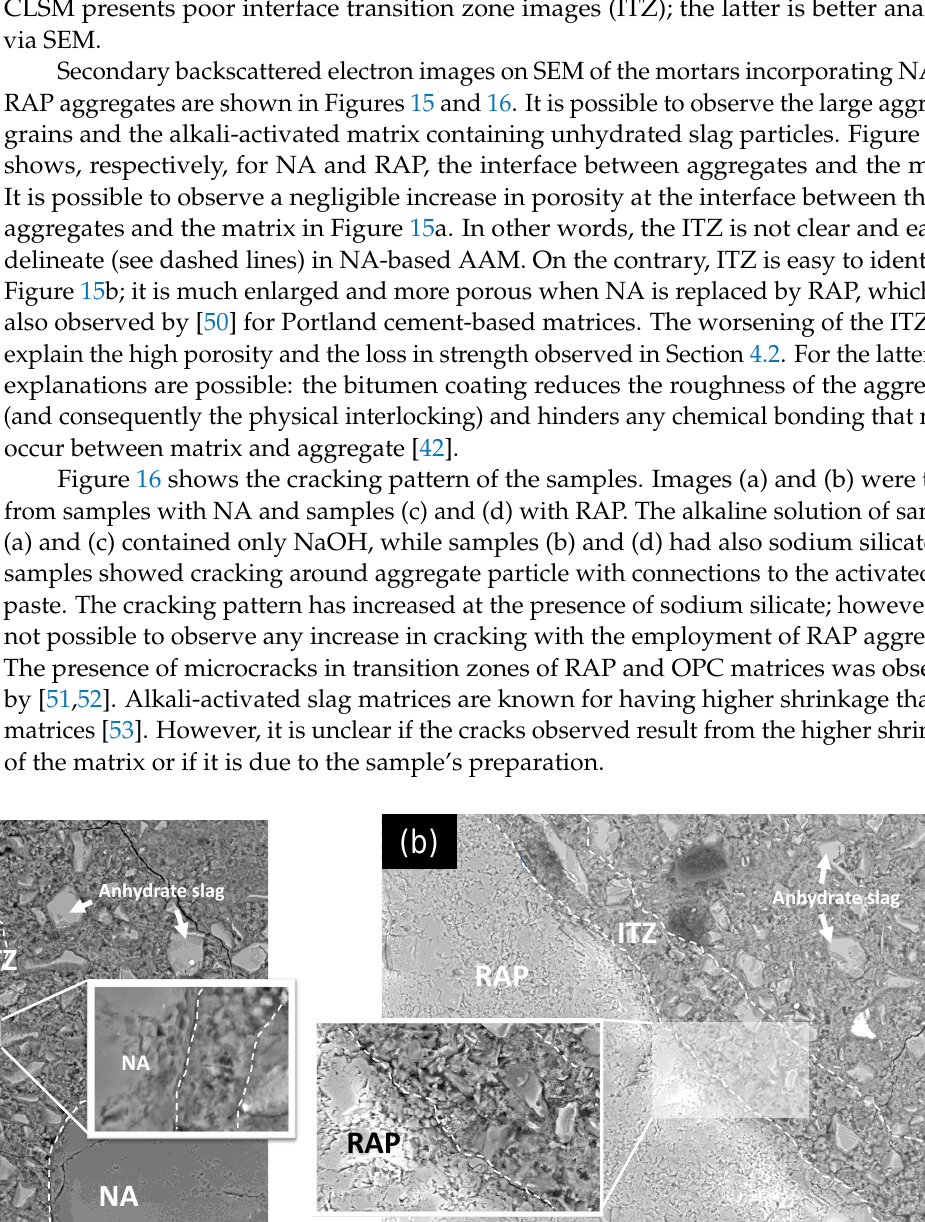
Figure 16. Evolution of cracking ( a ) N6M0, ( b )N6M1, ( c )R6M0, ( d ) R6M1. 5. Conclusions This paper studied the effect of different activator dosages on the properties and mi- crostructure of RAP — alkali-activated slag mortars (AAM). Natural aggregates (NA) were used as a reference. The following conclusions can be taken: